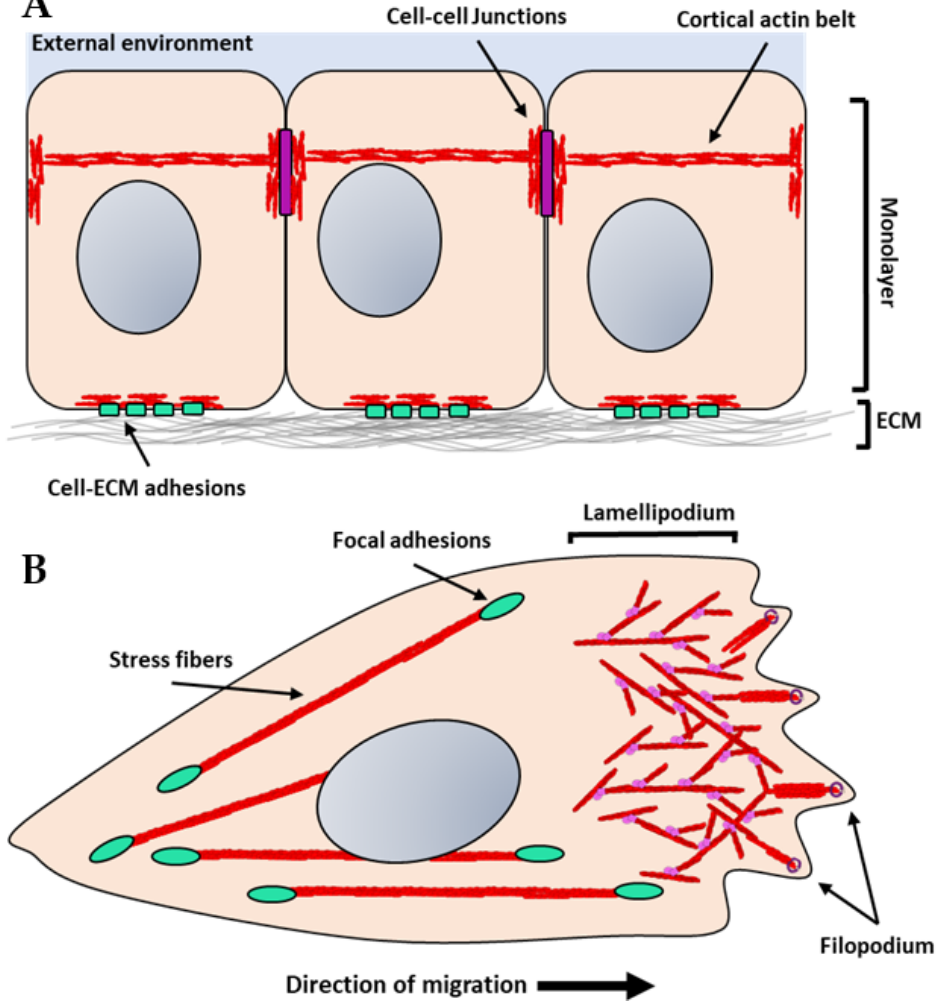
Figure 2. Illustration of actin architectures in monolayers and migratory cells: ( A ) Epithelial or endothelial cells form monolayers that are connected through cell–cell adhesion complexes (purple rectangles). These adhesions are bound to the actin cytoskeleton and form a cortical actin belt. The cortical actin belt links adjacent cells together providing stability and enables mechanical stimuli to be transmitted quickly throughout adjacent cells. These cells also engage with the extracellular matrix (ECM) at the basal interface through adhesion receptors such as integrins (light green). Integrins cluster forming stable focal adhesions, which bind to the actin cytoskeleton through adaptor proteins. ( B ) Migratory cells form extensive branched actin networks towards the leading edge of the cells known as lamellipodia. Small protrusions, known as filipodia, from the leading edge are filled with dense bundled actin. These structures generate protrusive force through both actin polymerization and non-muscle myosin II-mediated contraction. Formins are concentrated in the filopodia (purple), whereas the Arp2/3 complex (pink) is found in lamellipodia. Stress fibers are stable actin bundles that are stabilized by crosslinking proteins such as α -actinin and are generated at focal adhesion